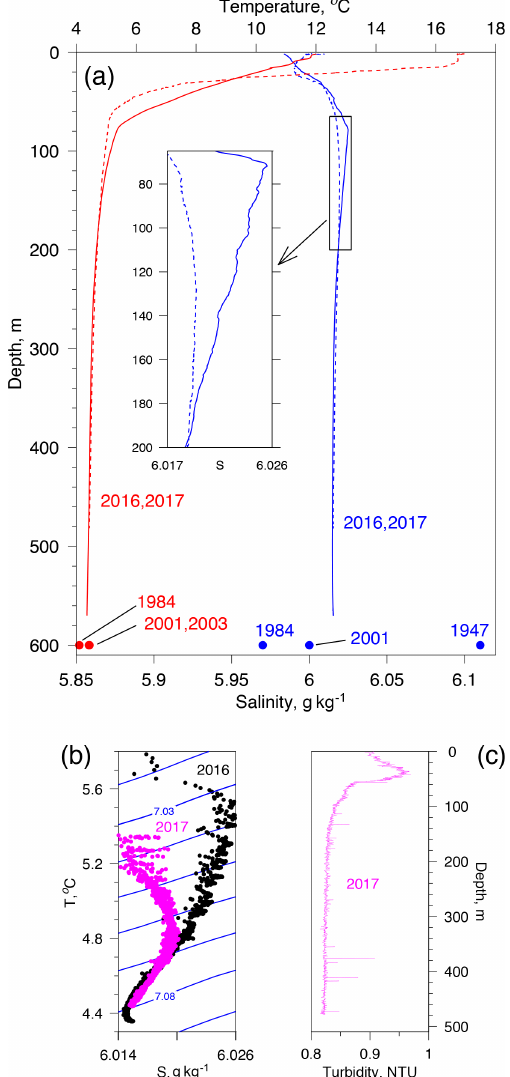
Figure 2. (a) Vertical profiles of temperature (red) and salinity (blue) observed on 31 October 2016 at 42.450 ◦ N, 77.044 ◦ E (solid), and on 29 June 2017 at 42.397 ◦ N, 77.100 ◦ E (dashed), and a sum- mary of available historical data for different years based on Kady- rov (1986), Romanovsky (1991), Peeters et al. (2003), and Ro- manovsky et al. (2013). (b) TS diagrams for water below the ther- mocline for October 2016 (black) and June 2017 (magenta); the blue lines are density ( ρ – 1000kgm − 3 ) isopleths for 40bar pres- sure calculated using the empirical formula by Peeters et al. (2003). (c) Vertical profile of turbidity in June